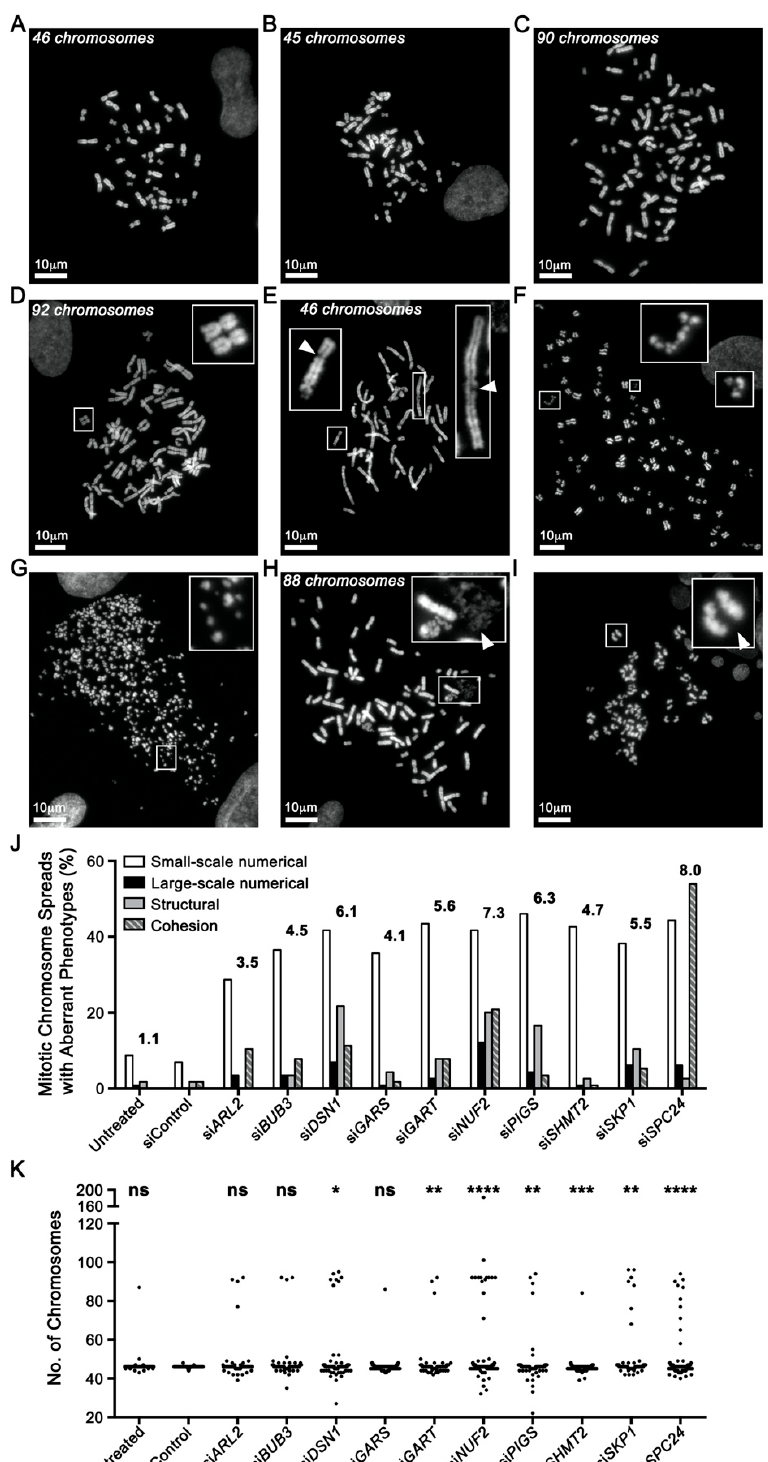
Figure 3. Gene Silencing Induces Numerical, Structural and Cohesion Chromosome Defects. ( A ) Representative mitotic chromosome spread from hTERT cells exhibiting the expected number (46) of chromosomes. ( B ) Aberrant chromosome spread displaying a small-scale numerical defect involving <15 chromosomes. ( C ) Large-scale numerical defect involving ≥ 15 chromosomes. ( D ) Endoreduplication resulting in paired homologous chromosomes (magnified inset) and a large-scale numerical defect. ( E – G ) Chromosome breakages (i.e., structural defects) increasing in severity from DNA double-strand breaks (DSBs) on individual chromatids ( E ; arrowheads), to extensive breaks along the length of the chromosomes ( F and G ; magnified insets). ( H ) Chromosome decompaction classified as a structural defect. Arrowhead highlights a region of chromosome decompaction. ( I )